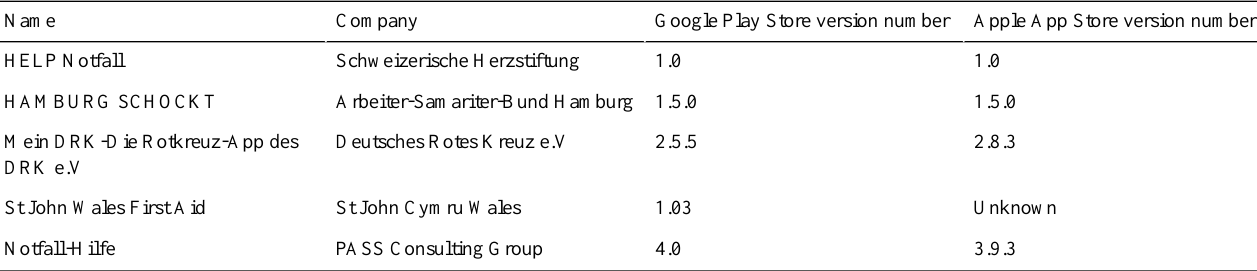
Table 1. Apps that met all 9 of our criteria for guideline